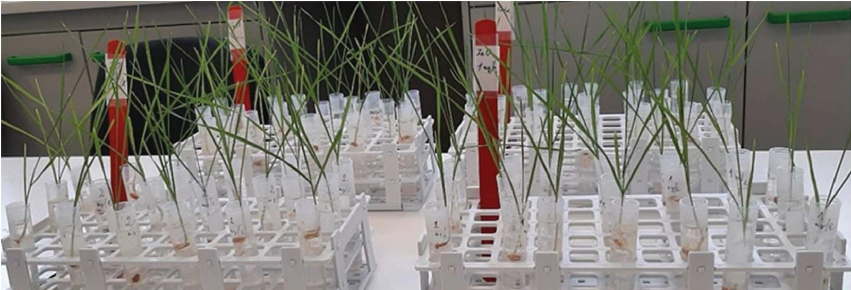
Figure 1: Samples of common wheat ( Triticum aestivum L.) seedlings grown in hydroponics for 15 days with diferent concentrations: 1, 2, and 4mg/l of ZnO